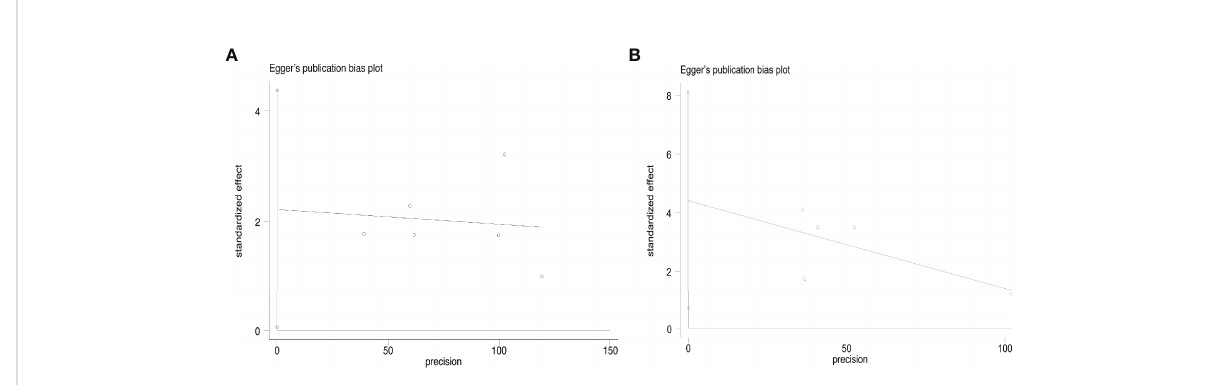
FIGURE 6 Forest plot of complication rate after thermal ablations: (A) T1aN0M0 and T1bN0M0 studies, (B) MWA and RFA